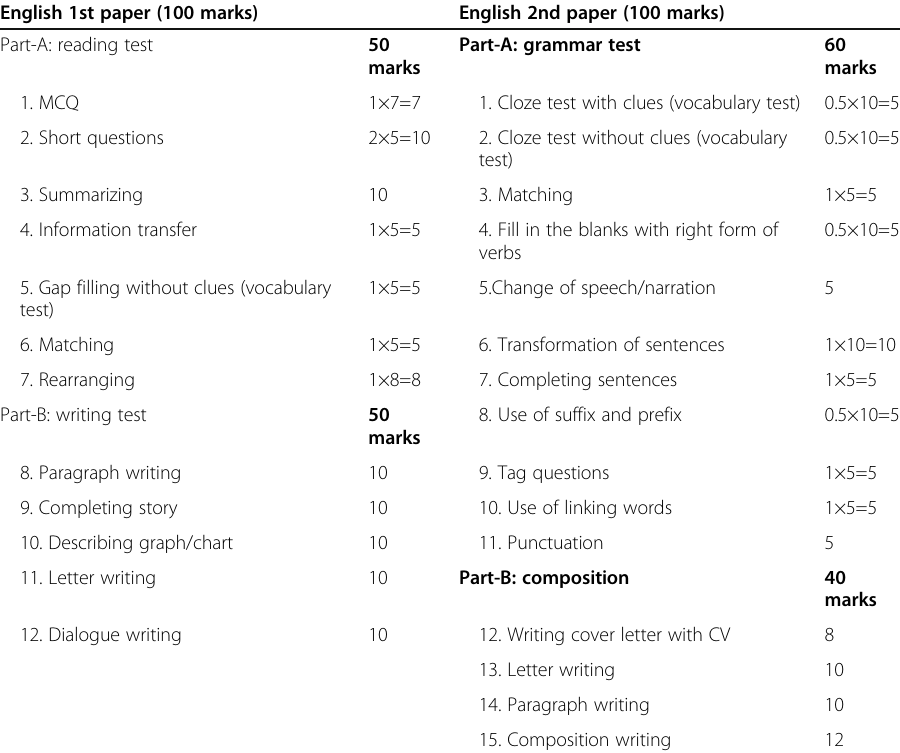
Table 2 English test item types (NCTB,